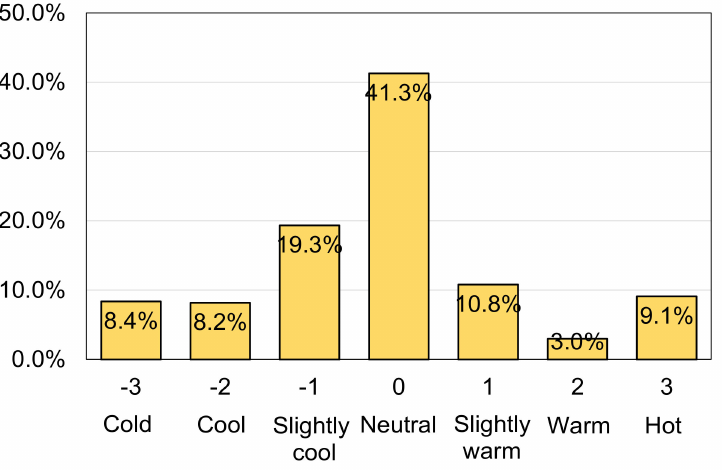
Figure 4. Distribution of the thermal sensation votes (TSVs) obtained during this